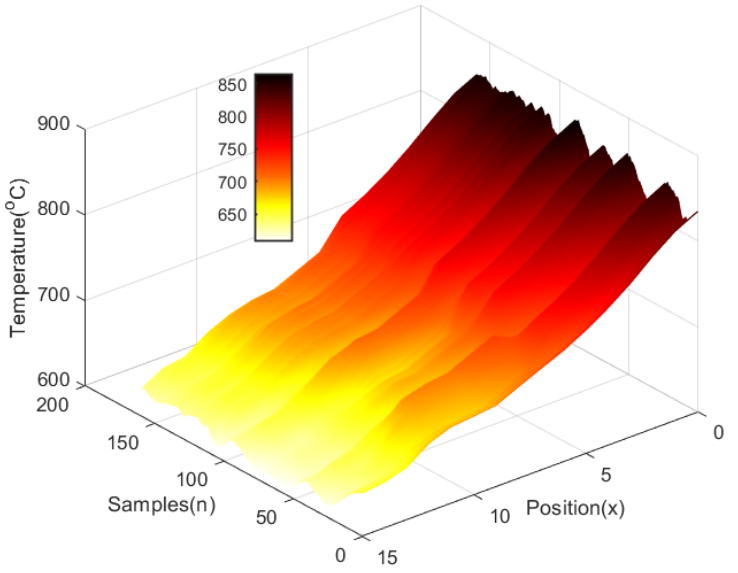
Figure 10. The spatial distribution of the strip temperature in normal condition. The verification above is carried out in the same specification. In order to validate the model with a different specification, data from four steel strips are used for the exper- iment ( G , FDT n , and CT n are different), as seen in Table 3. The comparison between the